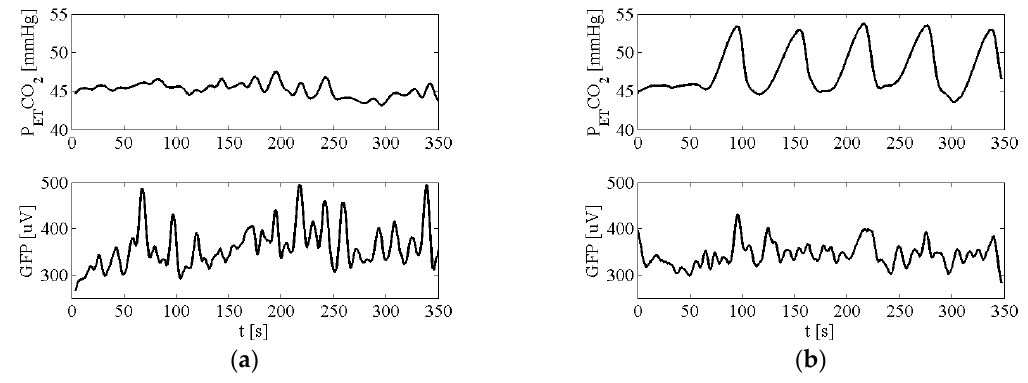
Figure 3. P ET CO 2 and GFP signals of Subject 4 recorded during FB task ( a ) and BH task ( b ).